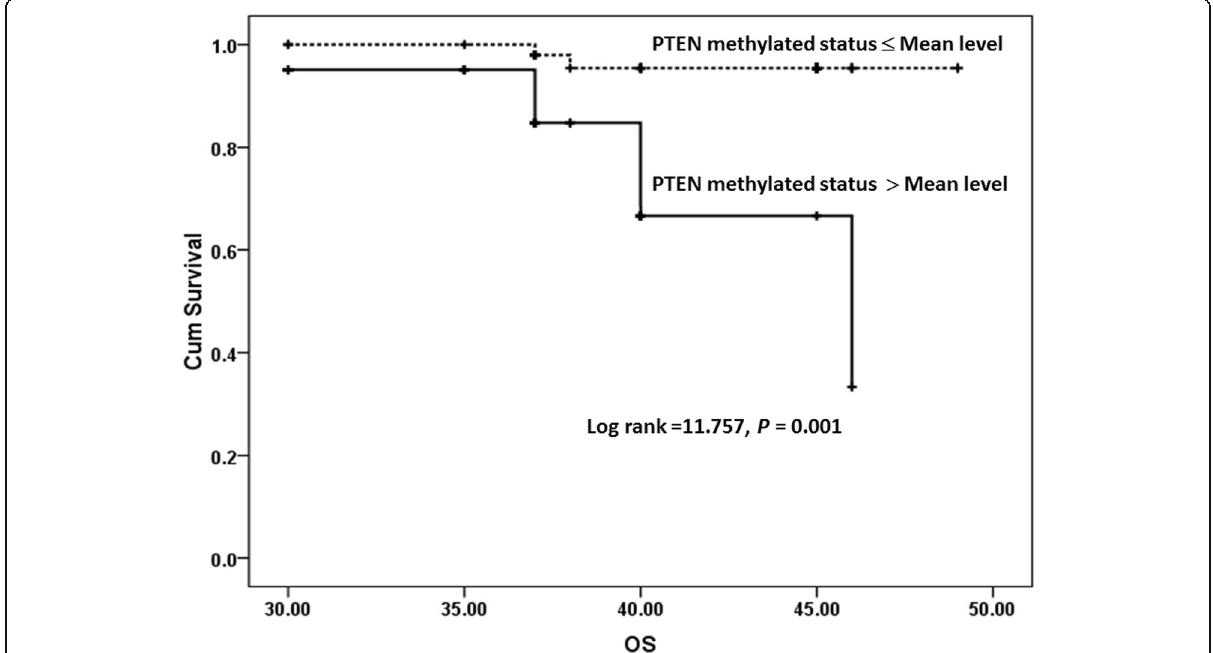
Fig. 4 Overall survival for PTEN methylation in BC